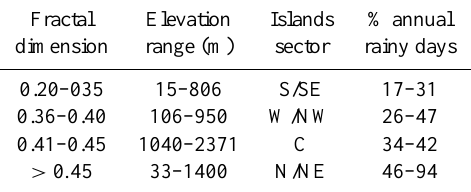
Table 3. Fractal dimensions ( D f ) of the rainfall data series and per- centage of annual number of rainy days at the Canaries. Daily data from automated and manual stations. Average period of measure- ments: